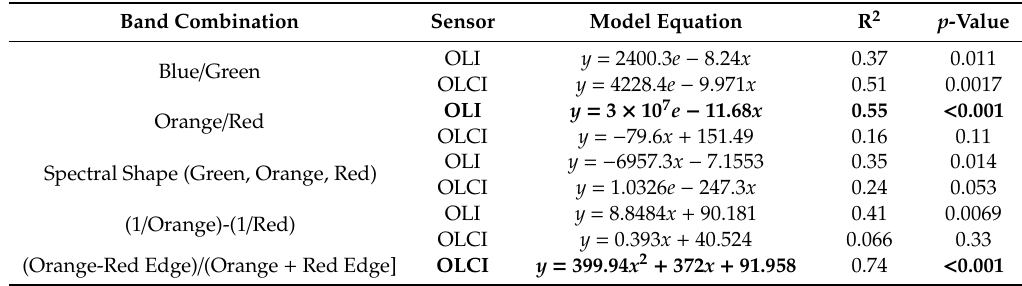
Table 2. Various band-combination-based PC model comparisons for the OLI and OLCI sensors. A total of 16 (n = 16) in situ PC concentration (PC range: 0.23 to 170.39 µ g / L) data were used in the regression analysis. The equations in bold were used to create the PC maps. Band Combination Sensor Model